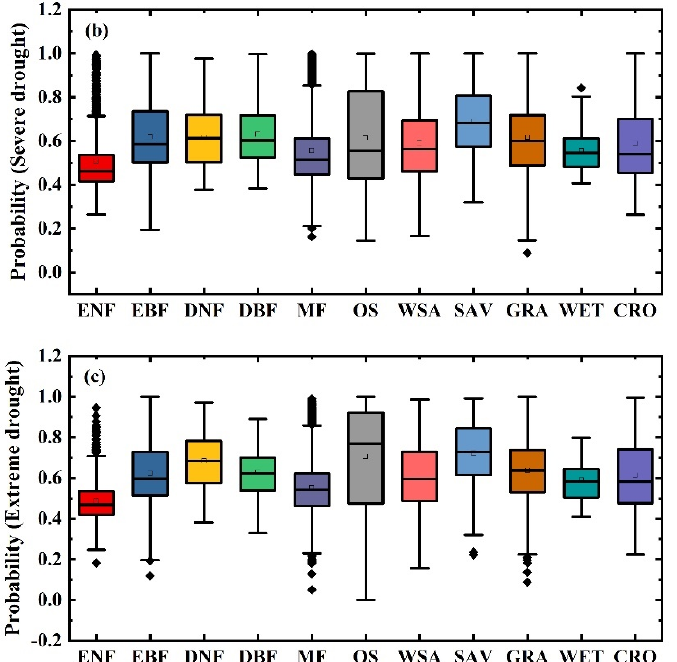
Figure 10. Conditional probabilities of vegetation productivity losses under different drought scenarios in different land cover types when the GPP ≤ 40th percentile in March–May. ( a – c ) represent conditional probabilities of vegetation productivity losses under moderate drought, severe drought and extreme drought, respectively. Boxes represent interquartile ranges of the values of 25th and 75th percentiles (Q 25 , Q 75 ), whiskers cover Q 25 − 1.5 × (Q 75 − Q 25 ) to Q 75 + 1.5 × (Q 75 − Q 25 ), horizontal lines represent the median, black empty squares represent the mean, and black solid diamonds indicate outliers.